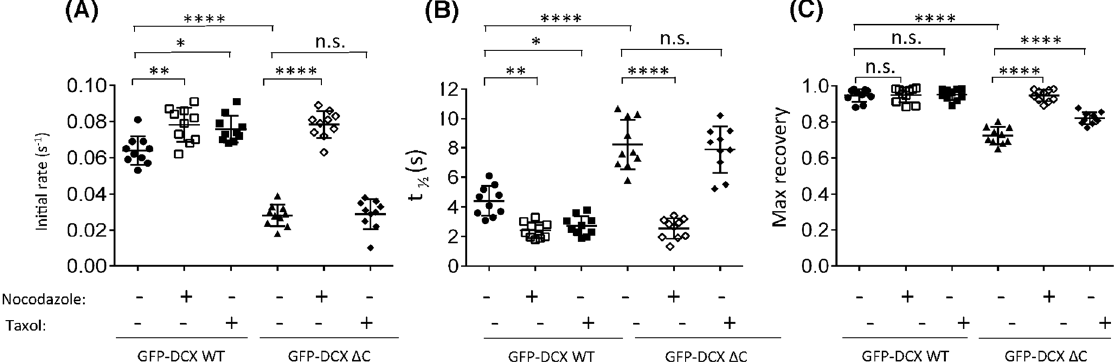
Figure 4. DCX C-terminal deletion slows dynamic association with MTs and decreases sensitivity to taxol- induced MT changes. ( A – C ) The recovery of the ROI fluorescence for GFP-DCX WT and GFP-DCX Δ C under basal, nocodazole or taxol treatments. Results are for the mean ± SEM for ( A ) the initial rate of recovery of fluorescence for GFP-DCX WT or GFP-DCX Δ C in the photobleached area (estimated over the initial 6 s post- bleach), ( B ) the time to reach half-maximal recovery of fluorescence (t 1/2 ), and ( C ) the fluorescence maximum recovery for GFP-DCX WT or GFP-DCX Δ C in the bleached area. Error bars represent the standard error of the means and asterisks indicate values calculated to be statistically significantly different ( * p ≤ 0.05, ** p ≤ 0.01, **** p ≤ 0.0001 n = 10 cells in each of three independent experiments. n.s. = not